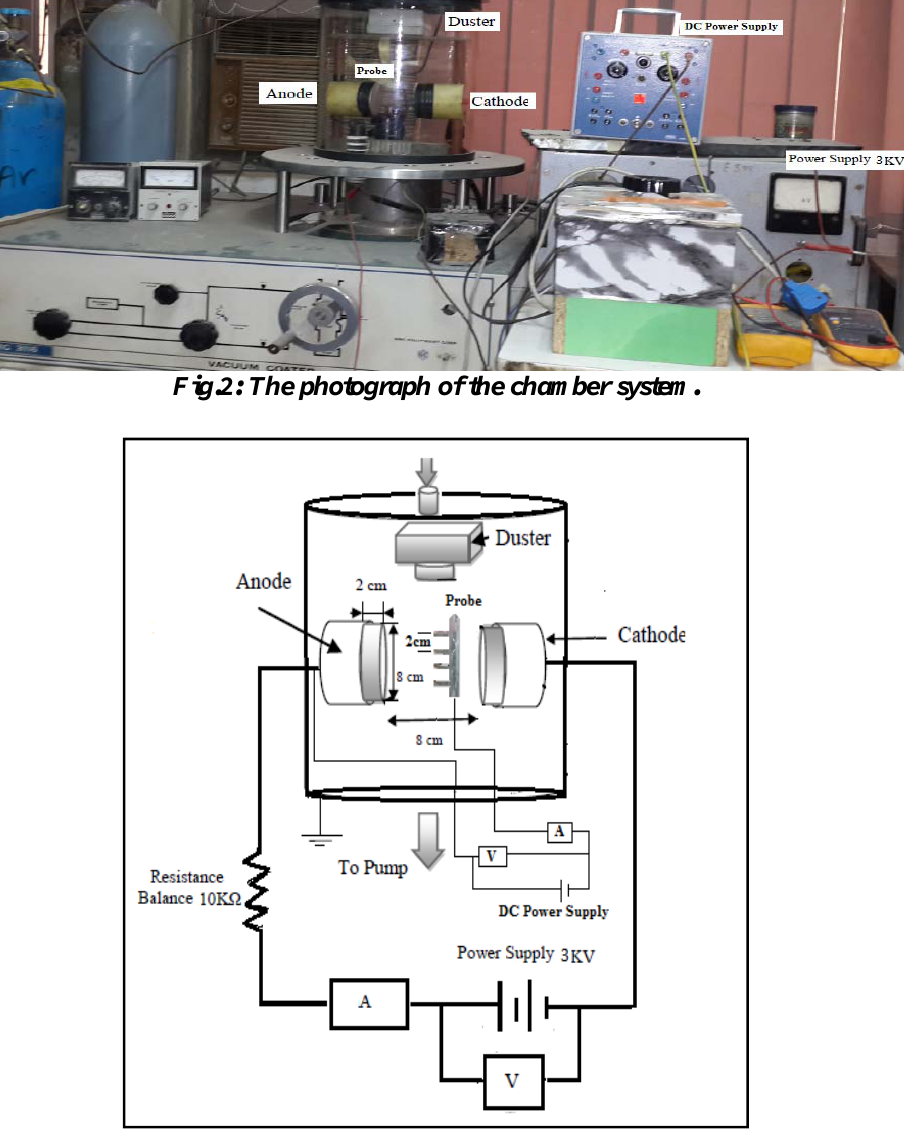
Fig.3: Schematic diagram of vacuum chamber with electric